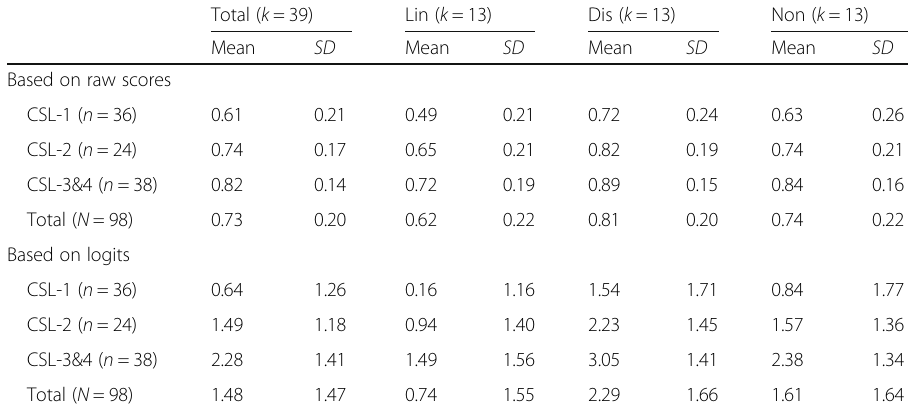
Table 5 Descriptive statistics of comprehension